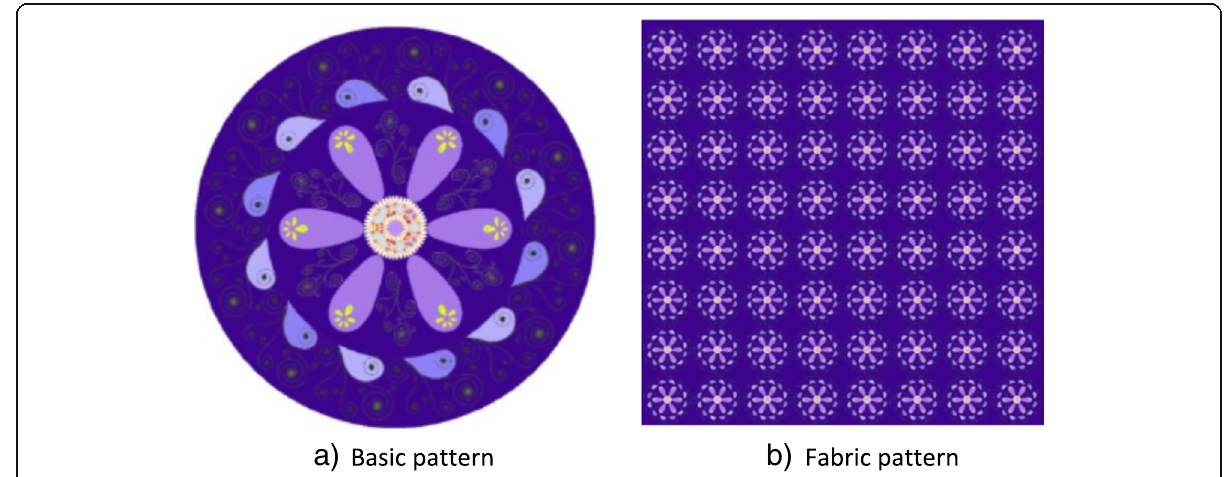
Fig. 17 Printing pattern design of garment fabrics 2